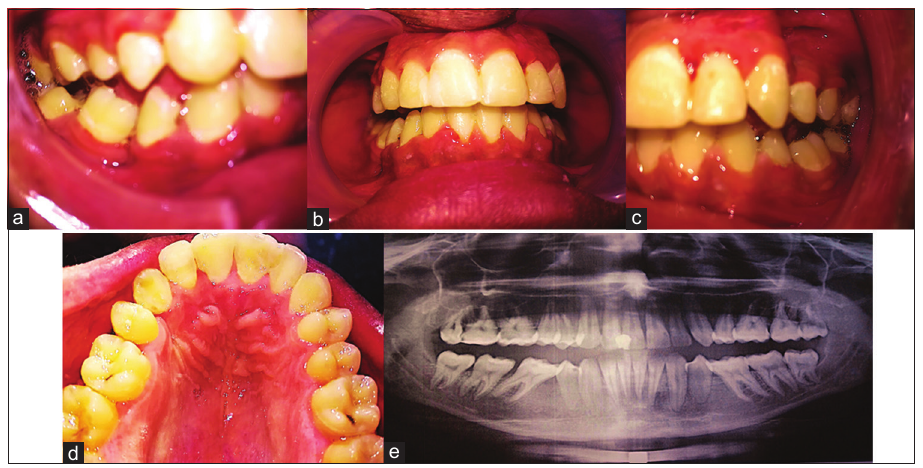
FIGURE 4. (a-e) Post-treatment intraoral photos and panoramic